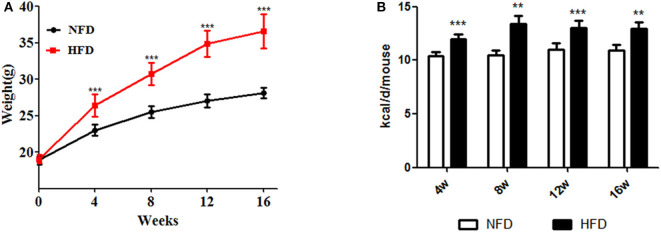
Changes in body weight and daily caloric intake during the development of obesity. Three- to four-week-old C57BL/6J male mice were fed a high-fat diet (HFD) for 4–16 weeks, with a normal-fat diet (NFD) as a control. (A) Body weight; (B) caloric intake. Data are shown as the means ± SD. **Compared to the NFD group, P < 0.01; ***compared to the NFD group, P < 0.005.